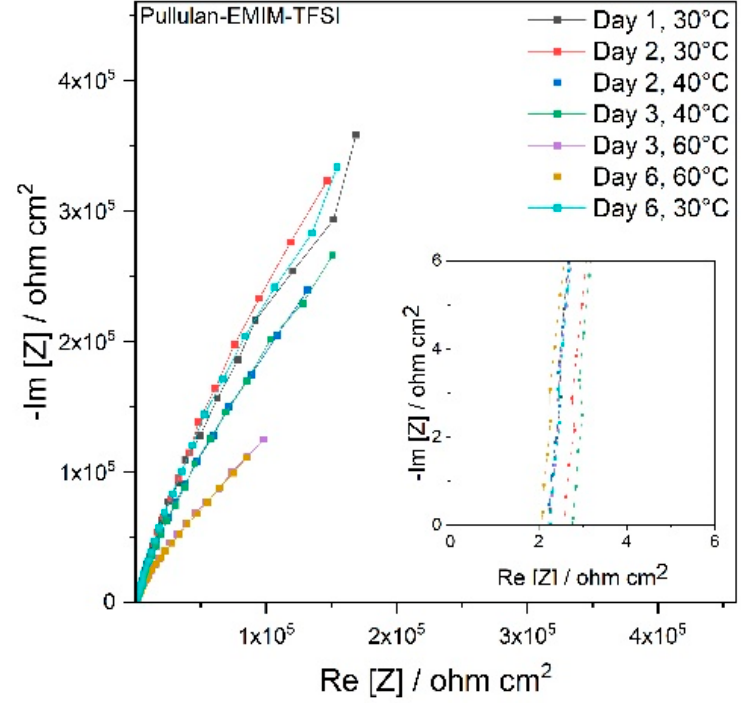
Figure 2. Nyquist plot of Pullulan electrospun membrane in EmimTFSI electrolyte.